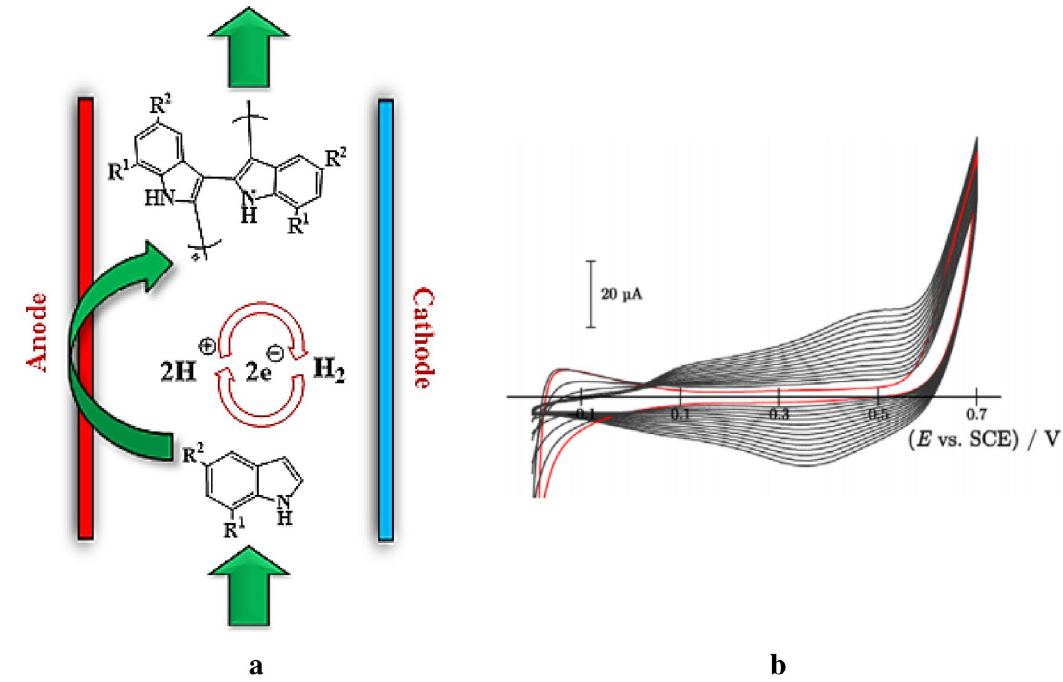
Fig. 2 a A systematic representation of electrochemical synthesis; b CVs acquired during the electrochemical synthesis of PIN